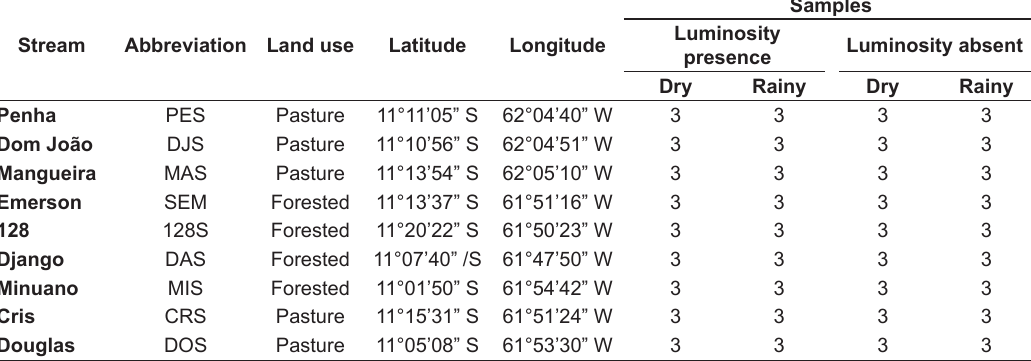
Table 1. Identification of collection site, abbreviation, land use in the adjacent matrix, geographical coordinates and number of samples of the nine streams in the Machado river basin, from July 2013 to May 2014. Stream